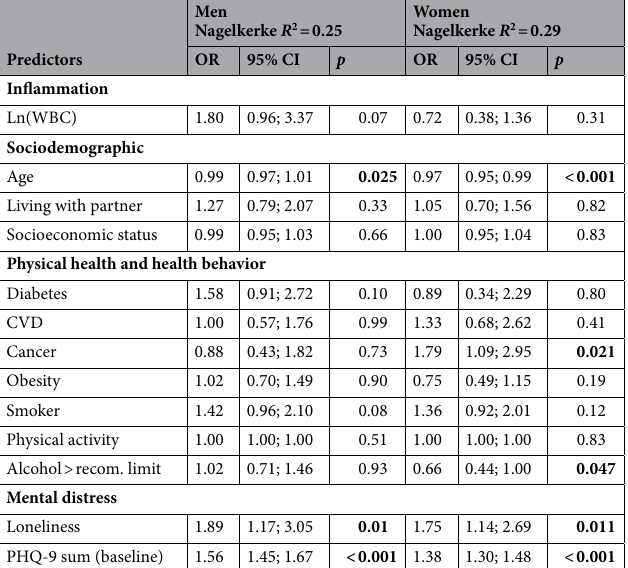
Men Nagelkerke R 2 = 0.25